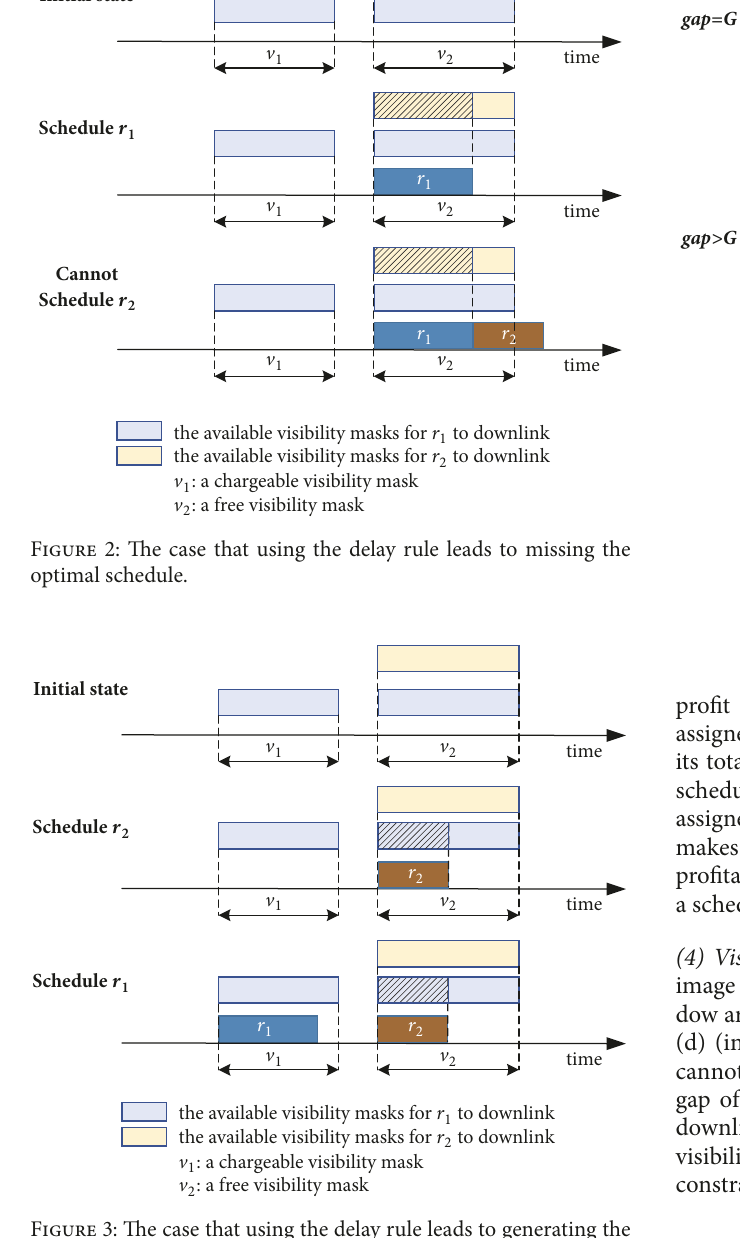
Figure 3: The case that using the delay rule leads to generating the optimal schedule.